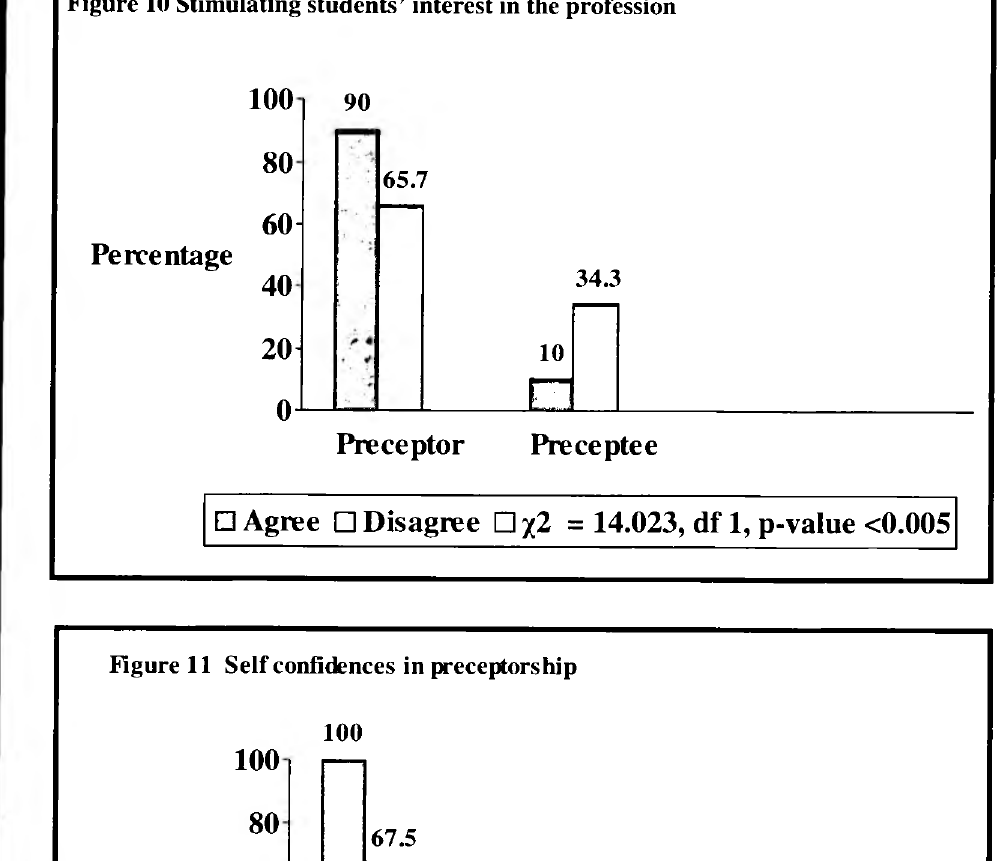
Figure 11 Self confidences in